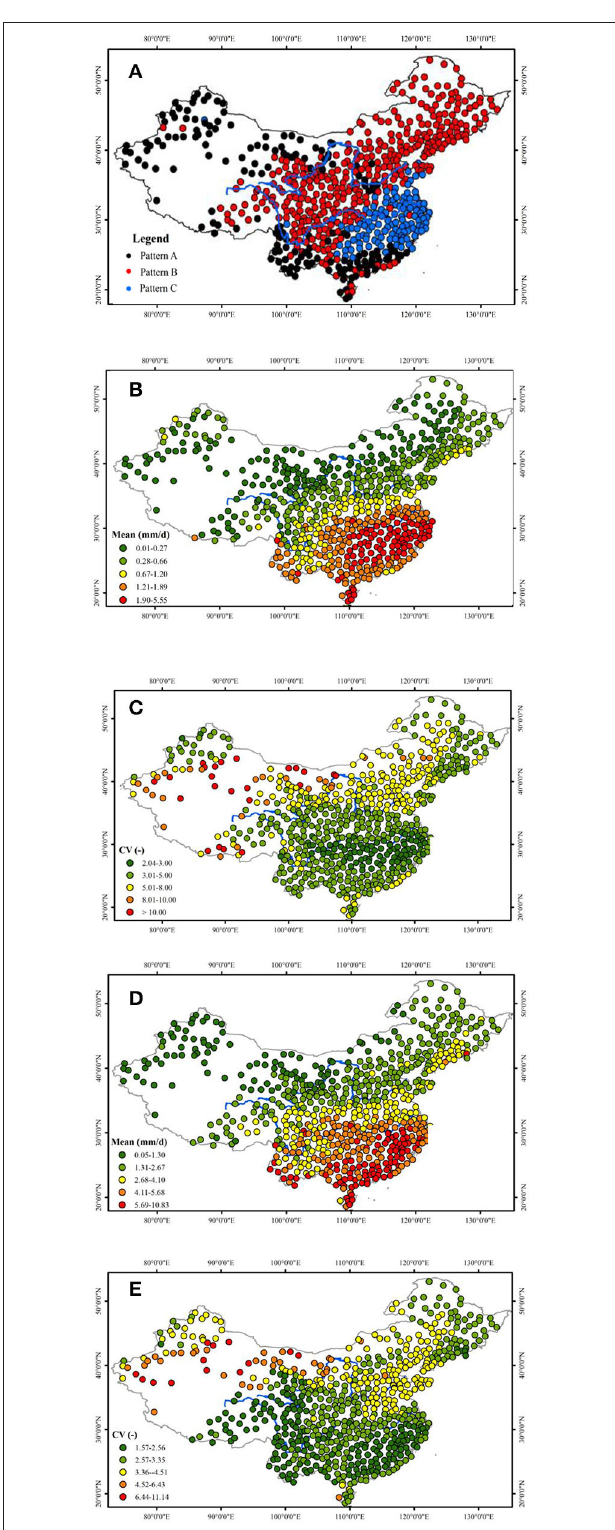
FIGURE 12 | The spatial distribution of precipitation MSE patterns over the studied area (A) the spatial patterns; (B,C) are the daily µ X and CV X , respectively, from October to February; (D,E) are the daily µ X and CV X , respectively, for the period from March to September. Maps cover only the study